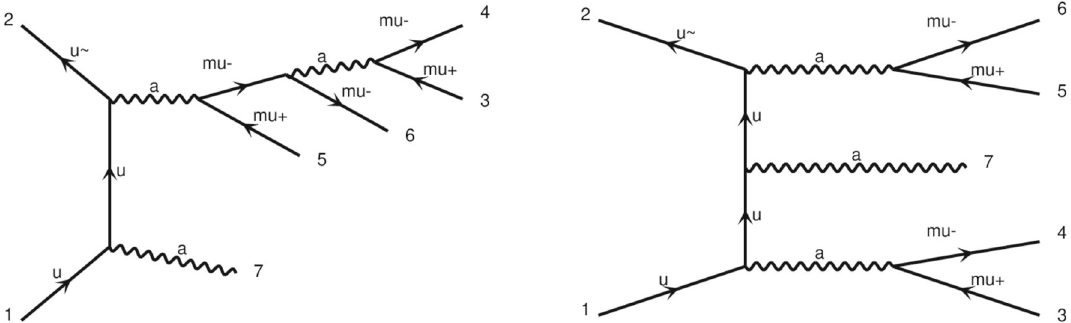
Fig. 3 Typical diagrams with photon radiation in the initial state or from the t -channel which were removed from MadGraph calculations of q ¯ q → μ + μ − μ + μ − γ process. Note that a stands here for either photon or Z